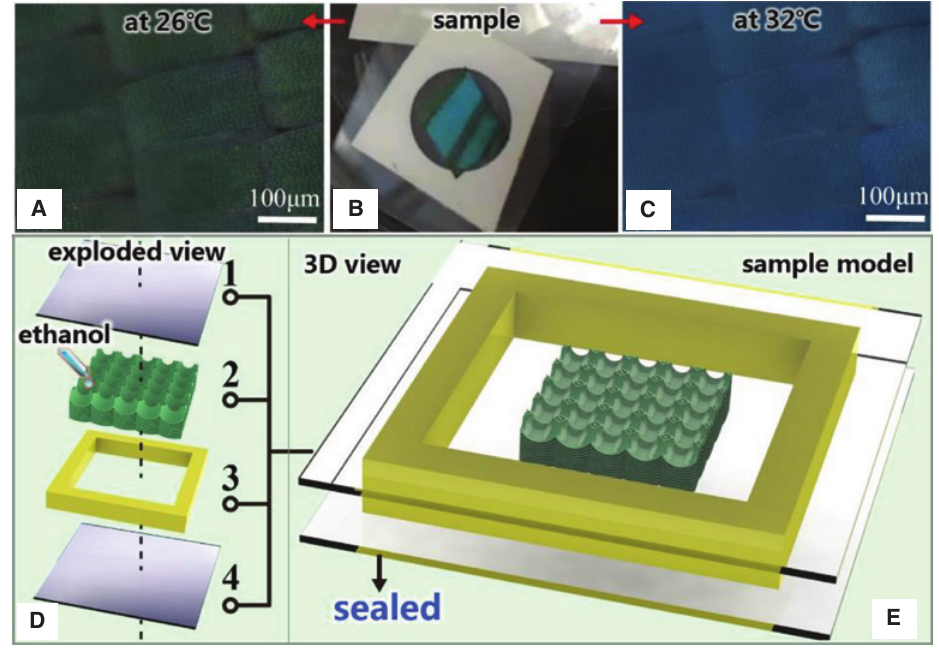
Figure 2: The LEF-PC sample fabricated by butterfly wing. (A, C) Optical microscopy images of the sample at 26 ° C and 32 ° C, respectively. (B) Digital photo of the sample, the wing was sealed by two layers of glass and double-sided tape. (D, E) Exploded view and 3D view models of the sample, part 1 and part 4 are glasses, part 2 is the butterfly wing saturated with ethanol, part 3 is the double-sided